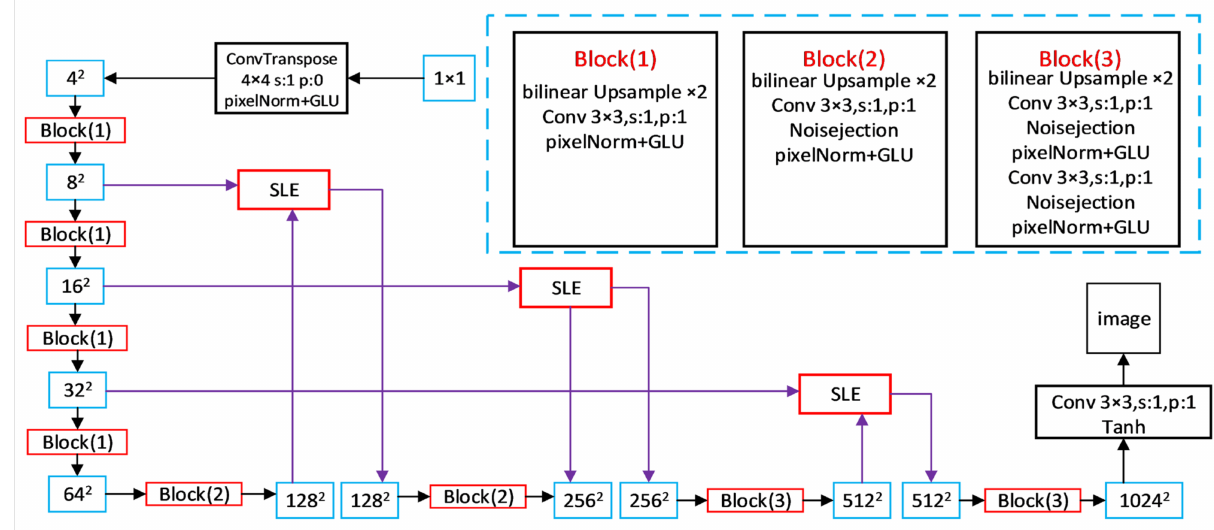
Figure 4. The redesigned generator structure. The blue dotted line frame contains three different upsample blocks. The blue solid line frame represents the size of the feature map, while the red solid line frame represents the SLE module in Figure 3.